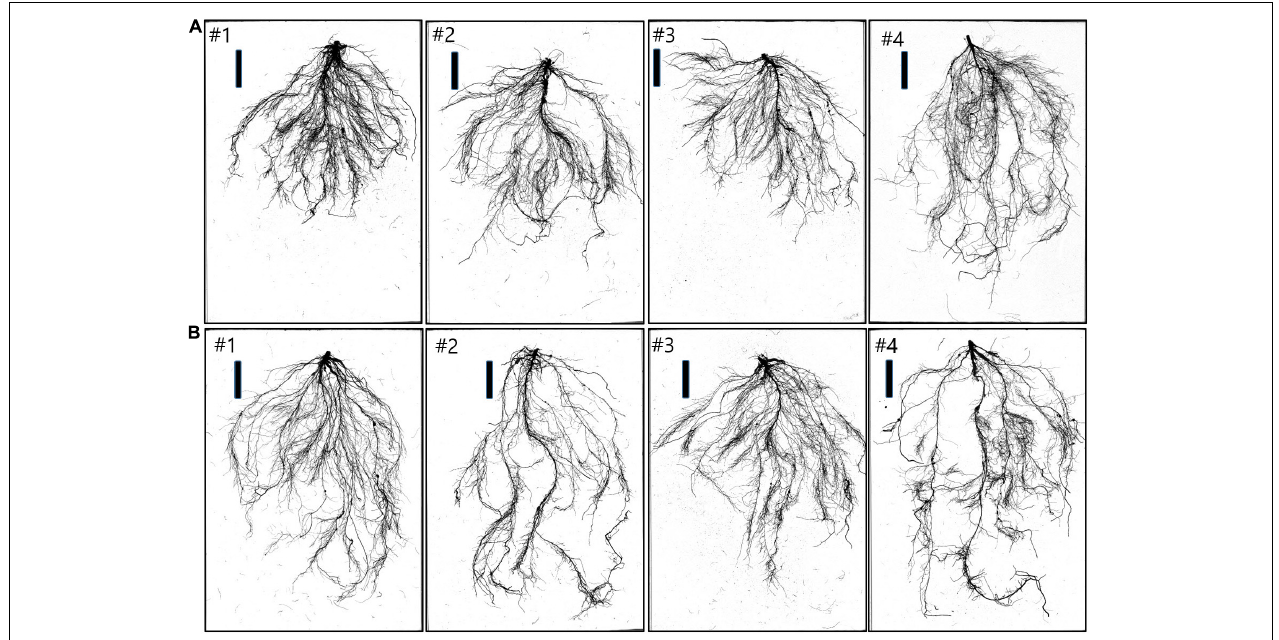
FIGURE 2 | Example of four soybean cultivars with root systems’ morphology 7 days after Si treatment. (A) Control root samples of cultivars (left to right): #1 (Geomjeongsaeol), #2 (Taeseon), #3 (Mallikong), and #4 (Somyongkong). Bar = 10 cm. (B) Si-treated root samples of cultivars (left to right): #1 (Geomjeongsaeol), #2 (Taeseon), #3 (Mallikong), and #4 (Somyongkong). Bar = 10 cm.